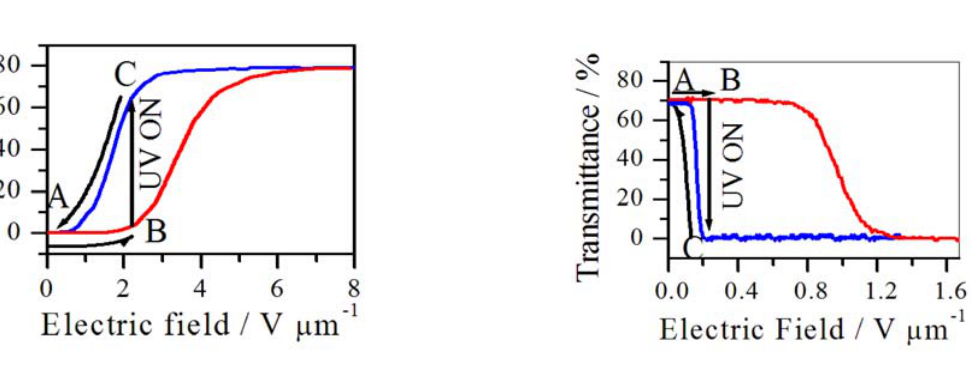
Figure 30. Transmittance dependence on the applied electric field in the dark (red curves) and under UV irradiation (blue curves) for a direct mode PDLC ( left ) and a reverse mode PDLC ( right